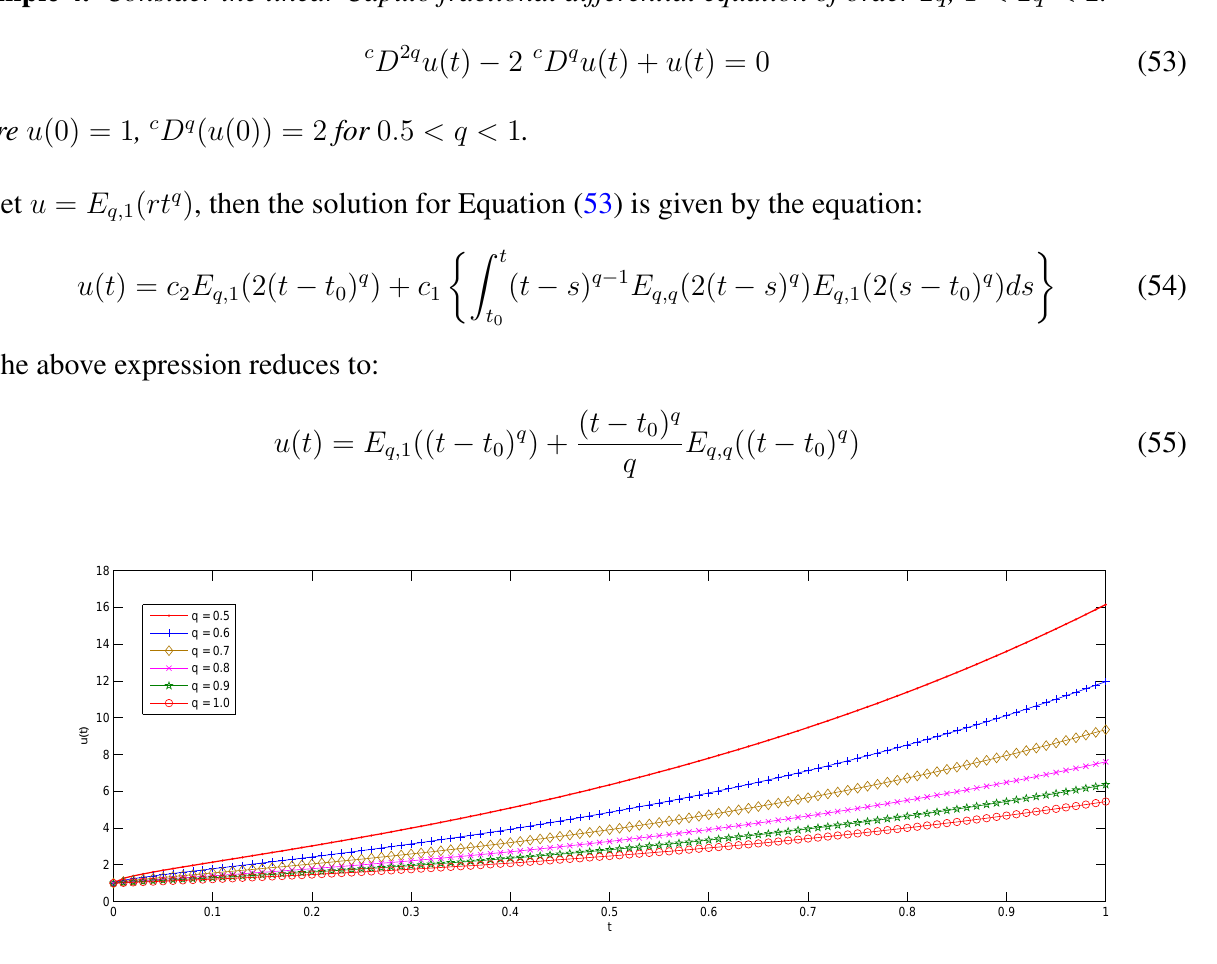
Figure 4. Graph for real and coincident roots when q = 0 . 5 , 0 . 6 , 0 . 7 , 0 . 8 , 0 . 9 , 1 . 0